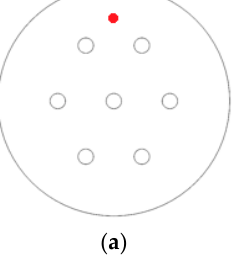
Figure 6. Orifice arrangement in the resonator cover: ( a ) Variant 1; ( b ) Variant 2; ( c ) Variant 3.